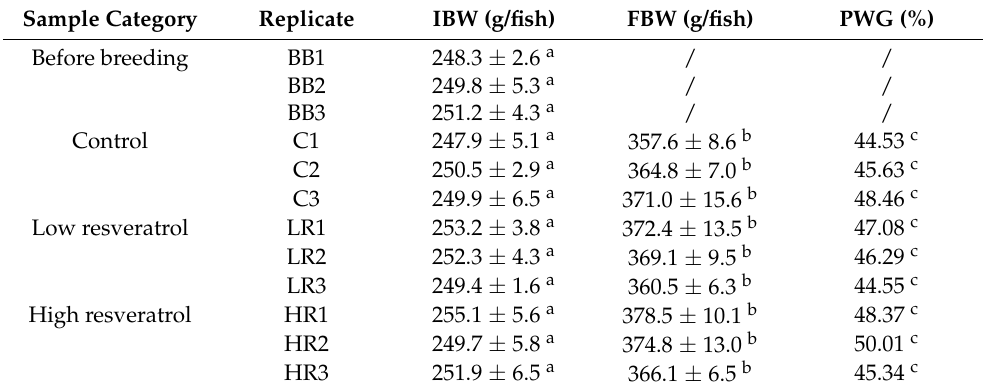
Table 1. The effect of resveratrol on the growth performance of Siberian